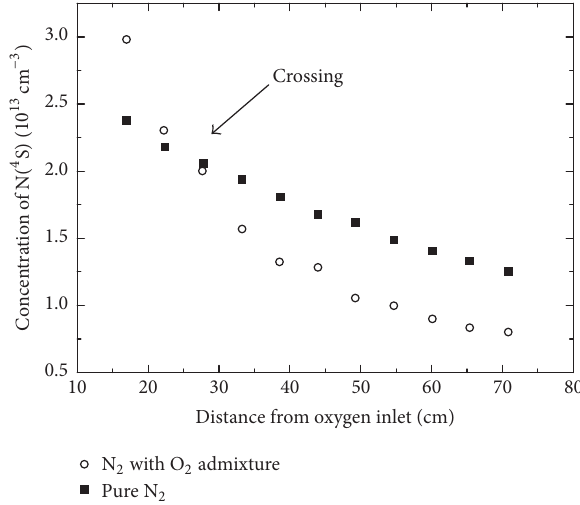
Figure 4: Spatial distribution of the nitrogen atom concentration (in ground state) along the afterglow tube for two cases: with and without 625 ppm oxygen